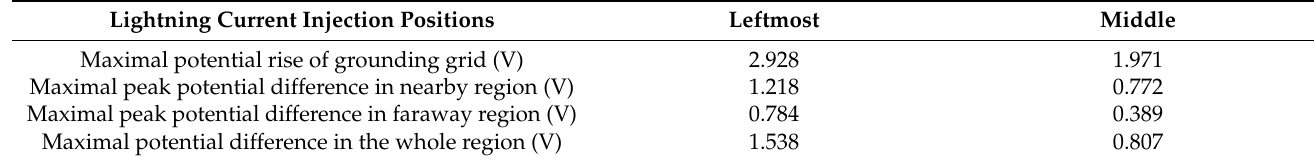
Table 1. Ground potential distribution under different lightning stroke